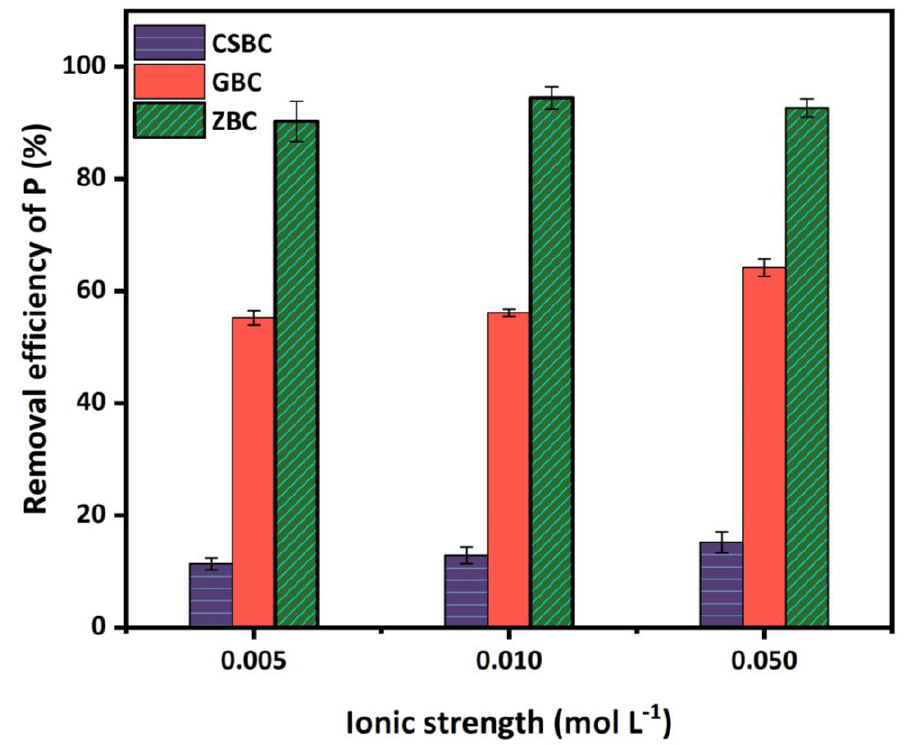
Figure 7. Effects of ionic strength on the P adsorption by CSBC, GBC, and ZBC. (Adsorbent dose: 5 g L − 1 ; P initial concentration: 15 mg L − 1 ; adsorption time: 4 h; pH: 6; temperature: 25 °C.)